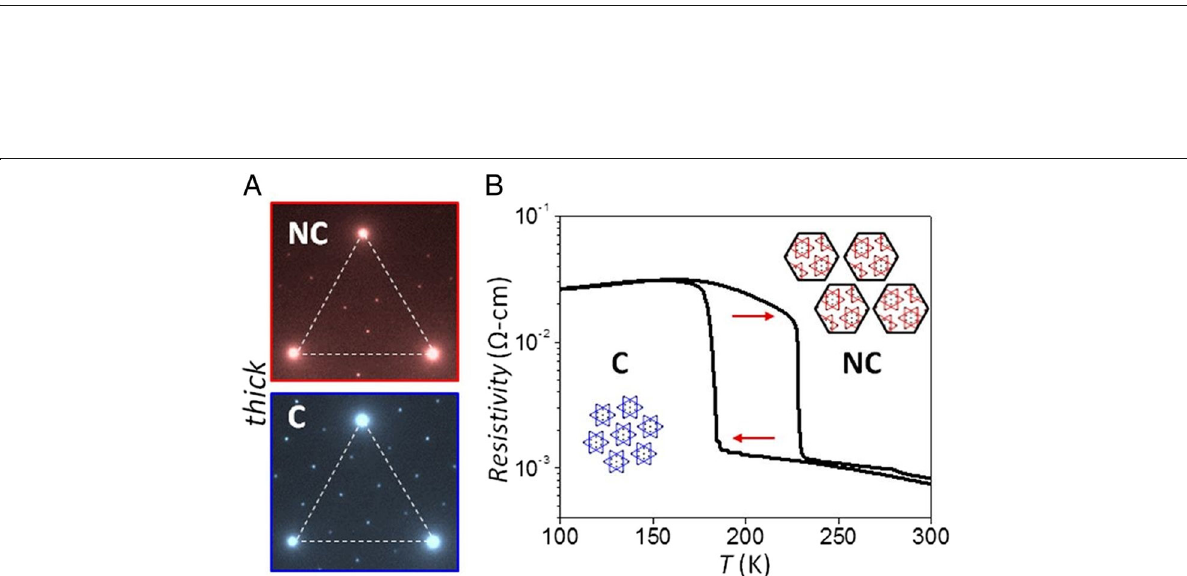
Fig. 3 a Experimental AC-HRTEM 1 T-TaSe2/graphene heterostructure at 80 kV. b Contrast variation due to the CCDW/PLD. c Simulated AC- HRTEM image of the CCDW/PLD in a single 1 T-TaSe2 layer. The Star of David structure is marked in blue. d The Fourier transformation of image ( a ) showing the PLD structure peaks. e Visible satellite spots of the CCDW/PLD. f Simulated kinematic electron diffraction pattern of the CCDW/ PLD in a single 1 T-TaSe2 layer. Reprinted from Börner et al. (2018) ( Appl. Phys. Lett. 113, 173,103) with Applied Physics Letters ’ permission